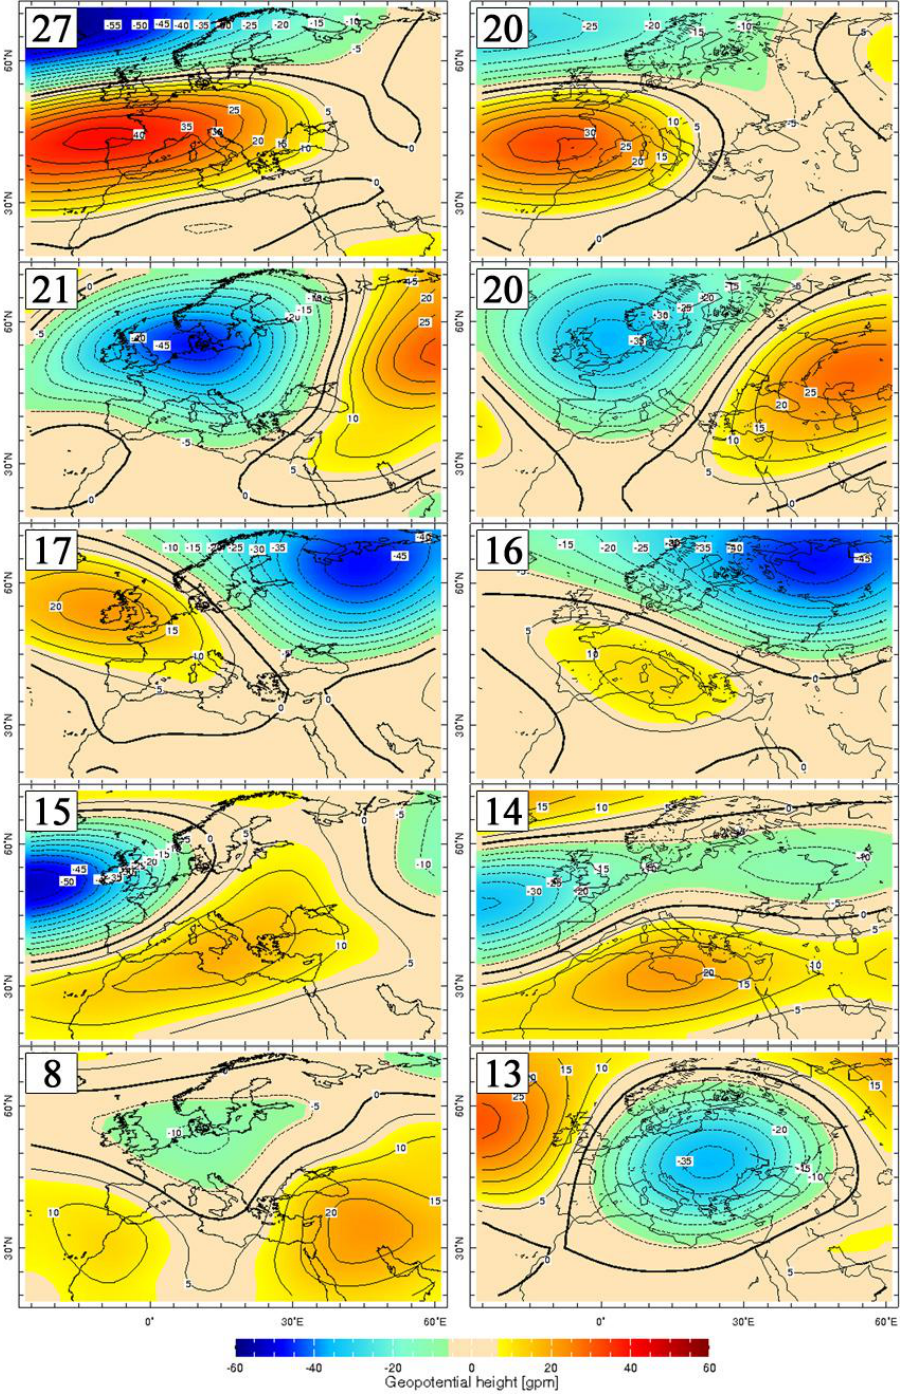
Fig. 9 809 Fig. 9. Varimax rotated EOFs of 500hPa gph, derived from observations (left panels) and the ensemble of all the 9 study models (right panels) calculated by pooling them together. The numbers denote the percentage of the variance explained by the pertinent EOF. The patterns are paired according to the spatial correlation between